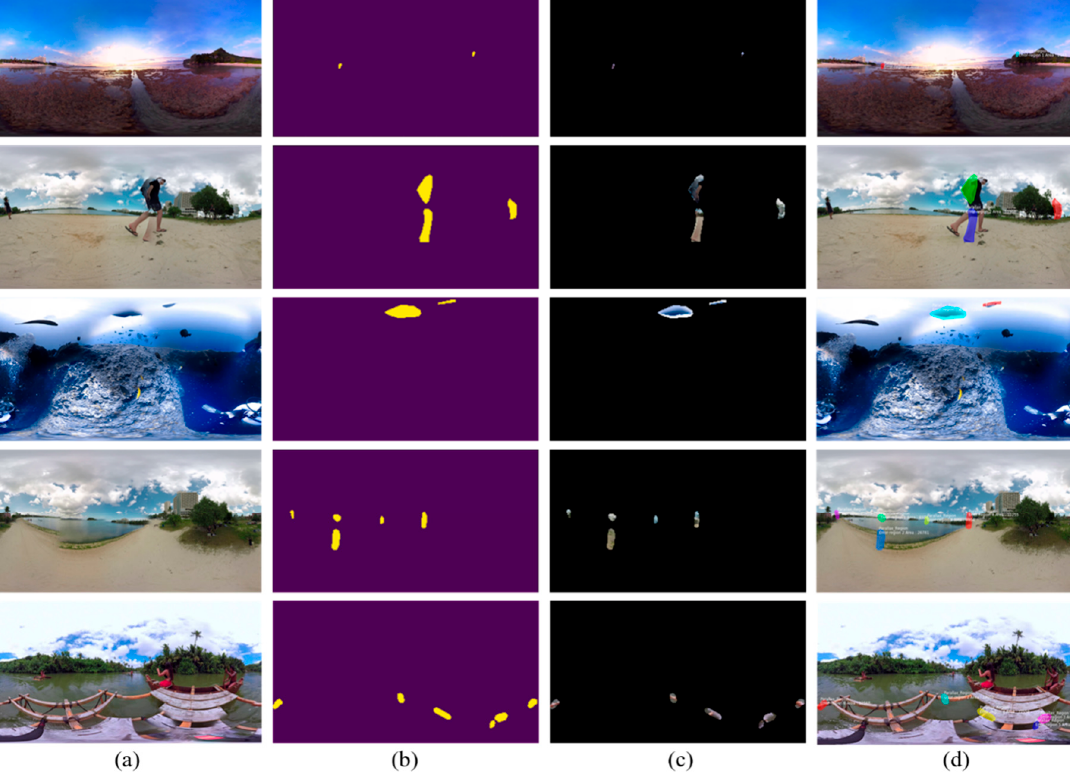
Figure 8. The segmentation results obtained for the distorted panoramic images test set: ( a ) input distorted panoramic image; ( b ) generated mask map; ( c ) distortion-specific panoramic image; ( d ) final segmented panoramic image.